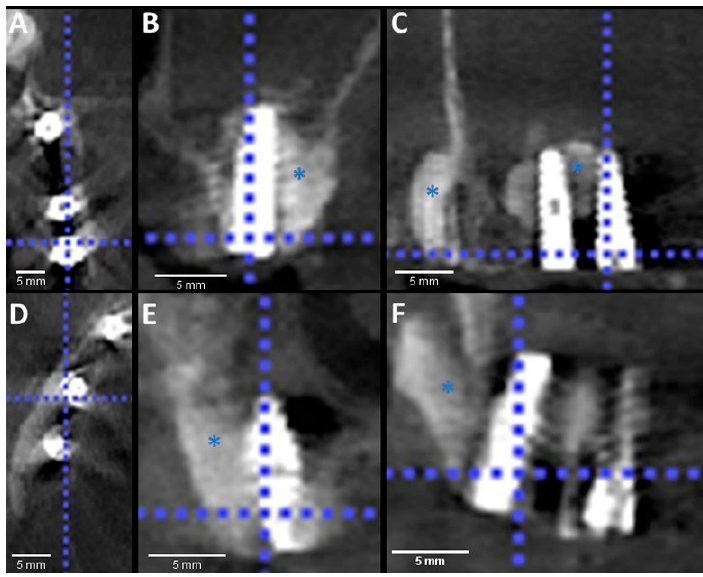
Figure 3. Postoperative CBCT imaging showed good integration between the cement, implant and bone. Paste-CPC is seen around the implants within the bone defect. Zoom enhanced axial ( A , D ), coronal ( B , E ) and sagittal ( C , F ) views, on the left side (upper panel) and the right side (lower panel). Blue asterisks mark the cement.